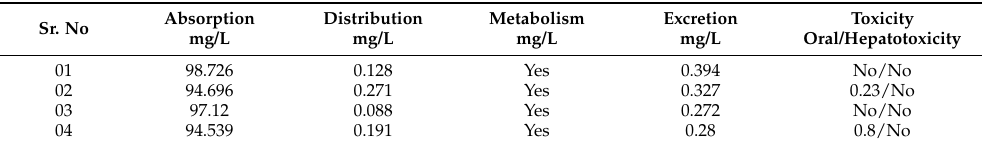
Table 3. Pharmacokinetics of the synthesized